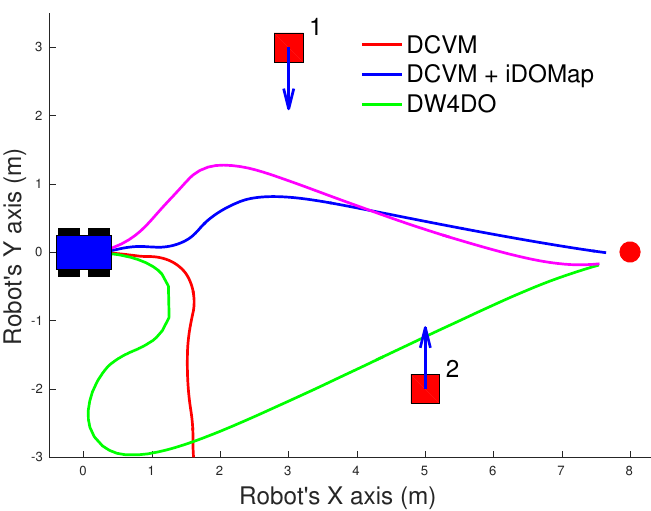
Figure 22. Scenario 1: Paths Results.